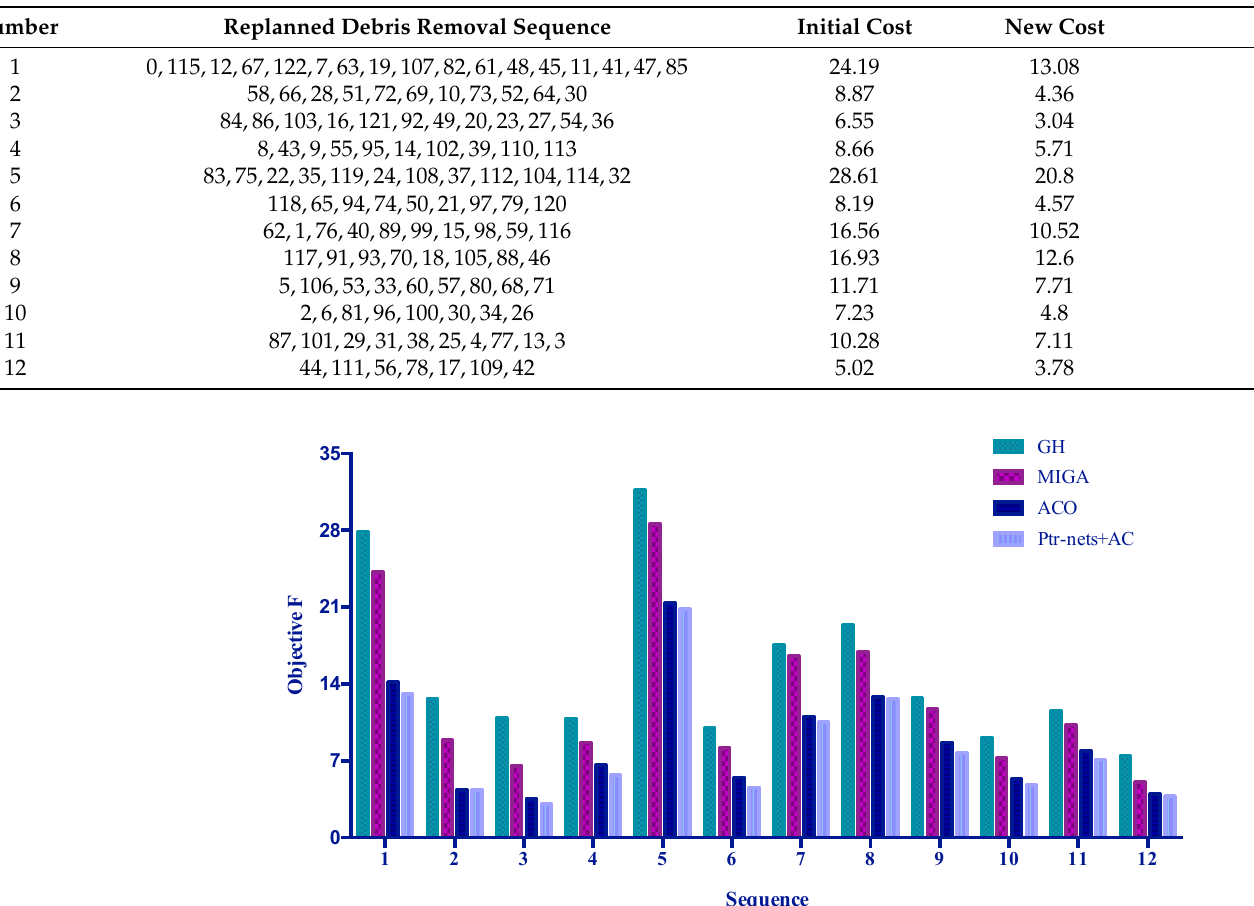
Table 11. The 12 replanned debris removal sequences by the Ptr-nets + AC algorithm.